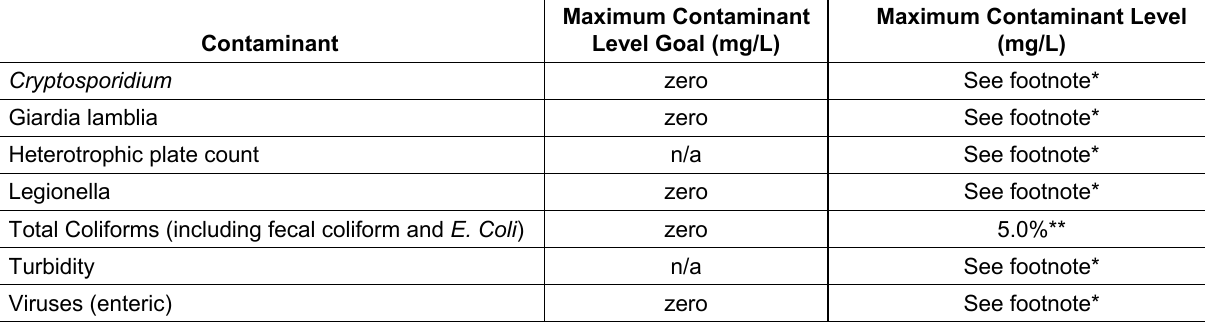
Table 1. EPA national primary drinking water standards for